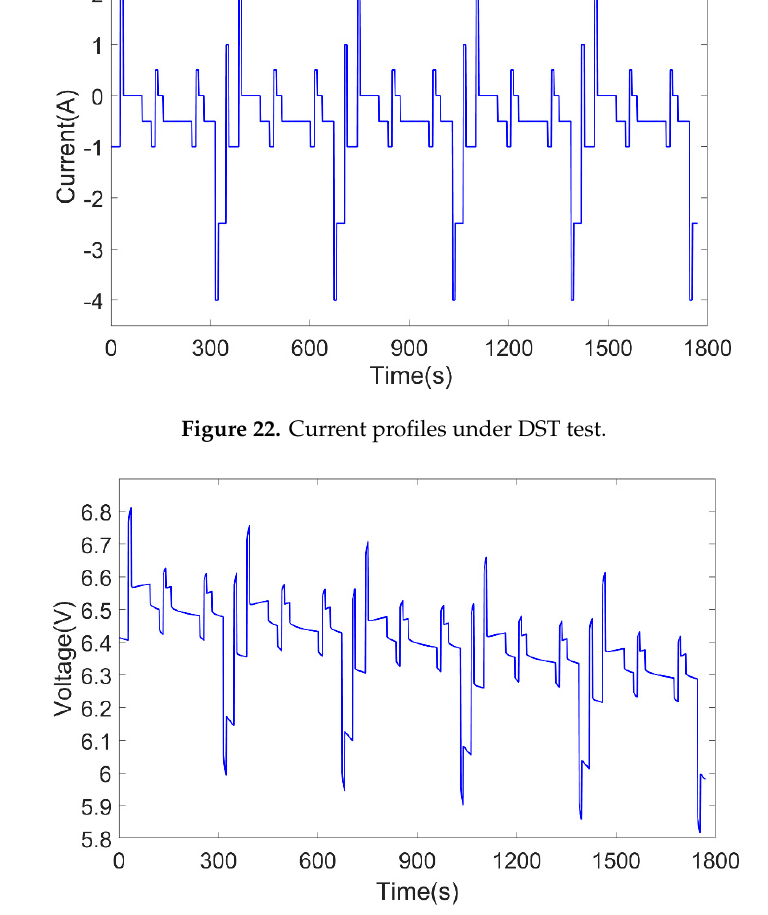
Figure 23. voltage profiles under DST test.